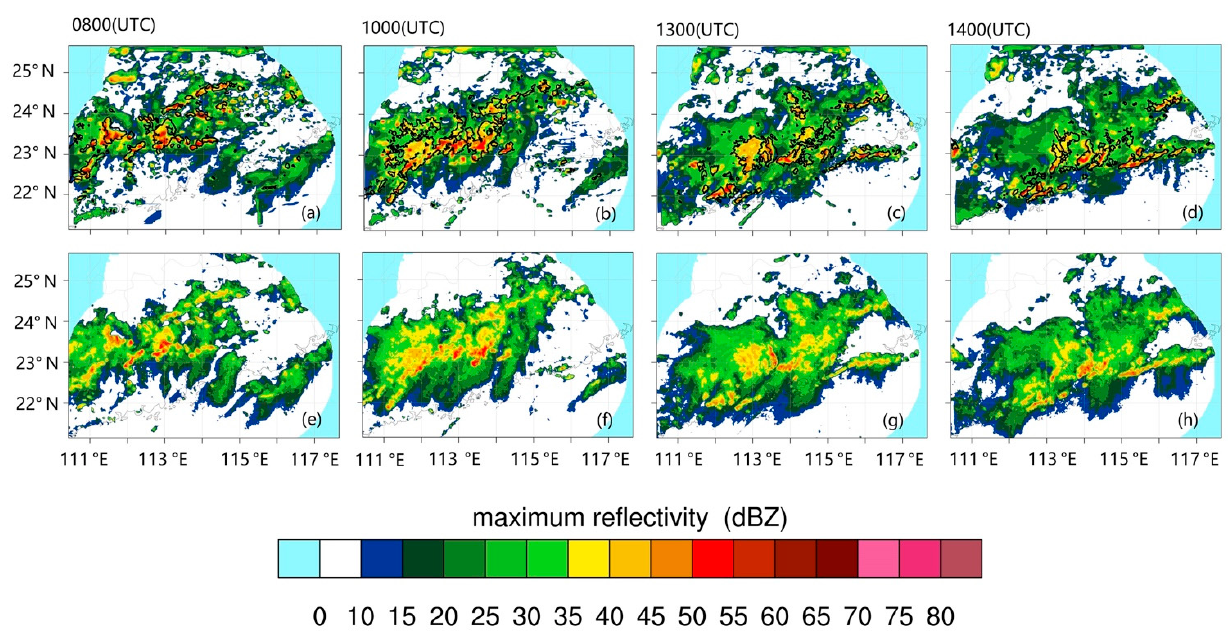
Figure 1. Composite radar reflectivity (dBZ) at ( a , e ) 0800 UTC; ( b , f ) 1000 UTC; ( c , g ) 1300 UTC; ( d , h ) 1400 UTC. ( a – d ) are from the simulations, and ( e – h ) are from the observations. The 35 dBZ reflectivity contours from the observations are shown in the panels of the correspondent simulations (in thick black). The areas out of the radar detection ranges are shown as light blue shades.